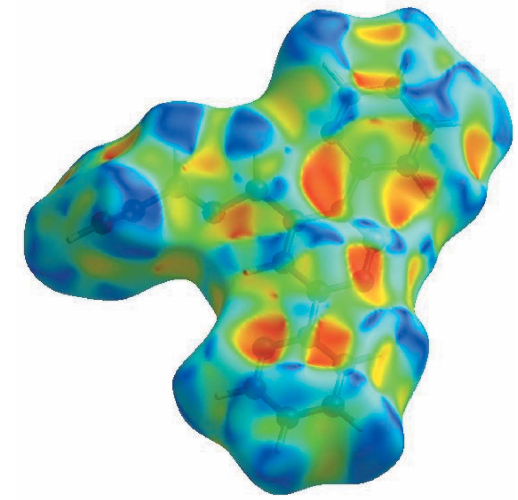
Figure 6 Hirshfeld surface of the title compound plotted over shape-index.